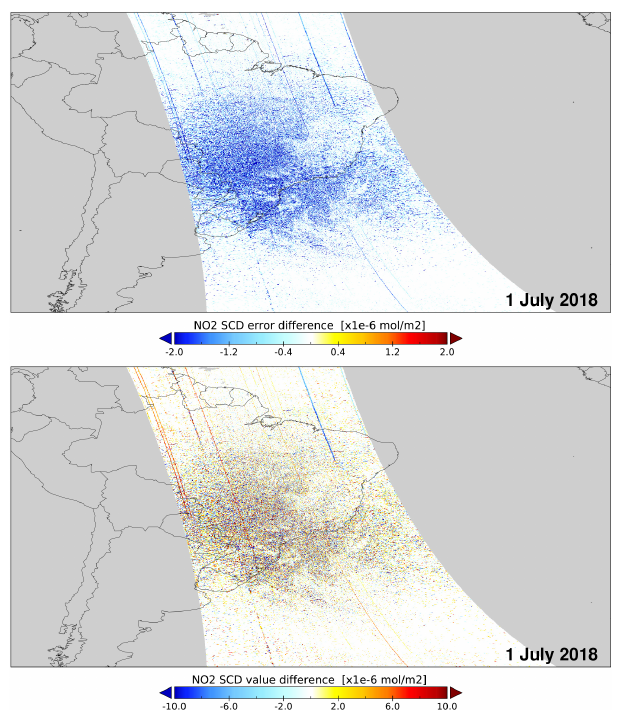
Figure 2. Map of the TROPOMI NO 2 SCD error (top panel) and SCD value (bottom panel) difference of orbit 03707 of 1 July 2018 over the South Atlantic Anomaly (SAA) due to outlier removal, i.e. the SCD error using the v2.1 settings minus those using the v1.2 settings listed in Table 2, both with level-1b v2.0 spectra as input. The depicted area is longitude [ − 80 to − 10 ◦ ], latitude [ + 50 to + 10 ◦